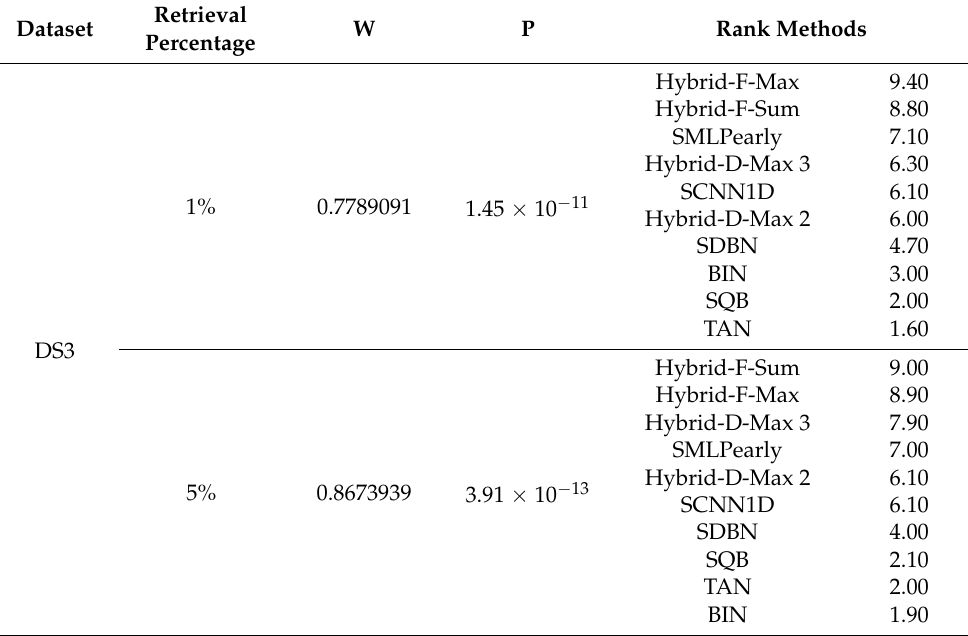
Table 15. Ranking of hybrid Siamese similarity models based on (TAN, BIN, SQB, SDBN, SCNN1D, and SMLP) using Kendall W test results for DS3, at top 1% and